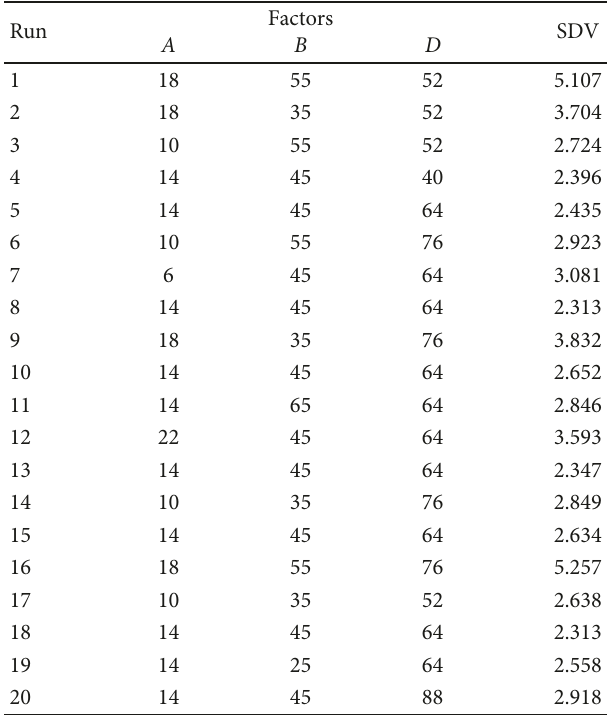
Table 6: Composition of various runs of CCD and simulation results.